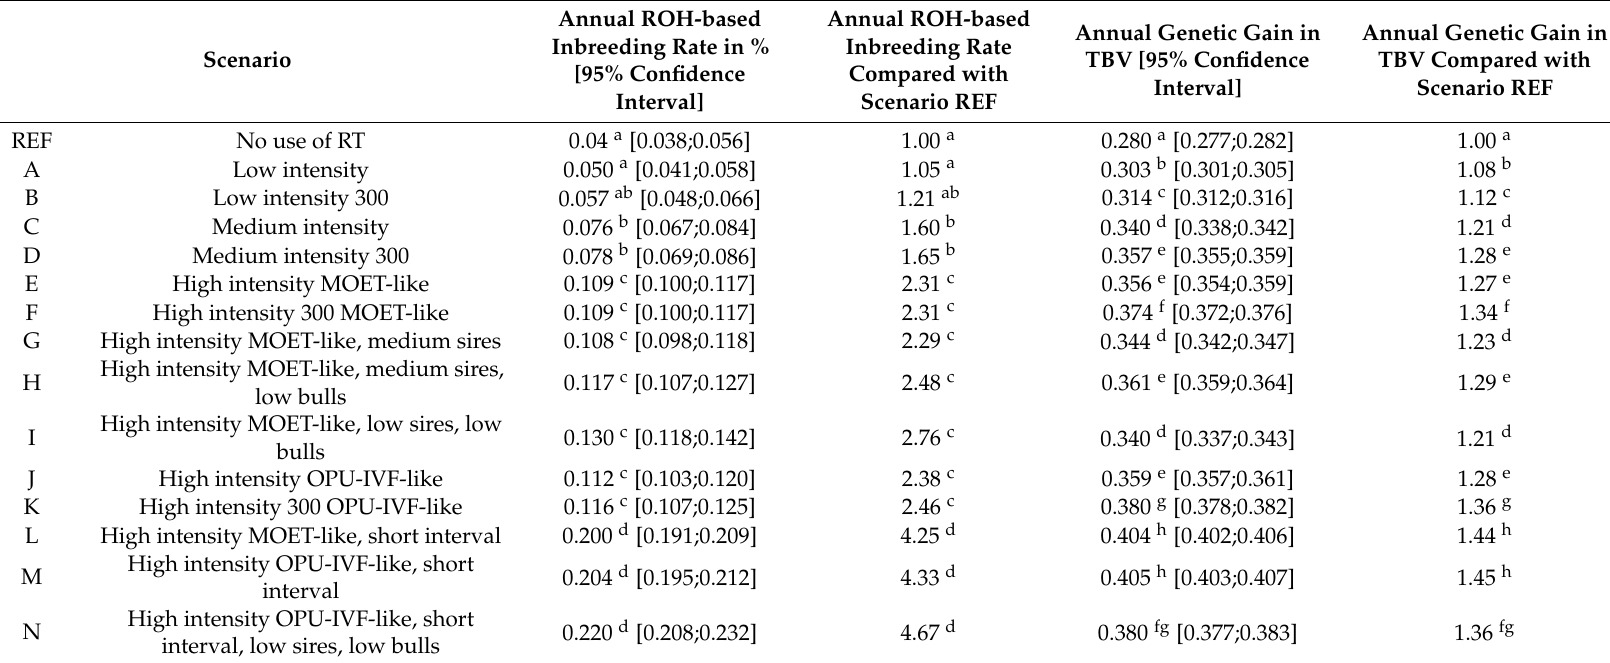
Table 3. Annual ROH-based inbreeding rate versus annual genetic gain among sires and bulls. Scenario